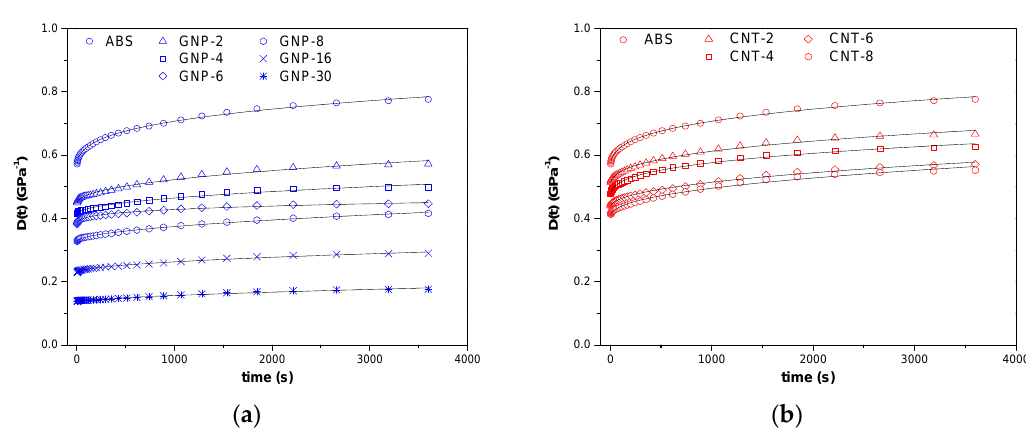
Figure 6. Creep compliance of nanocomposites with ( a ) graphene and ( b ) carbon nanotubes at 30 °C at 3.9